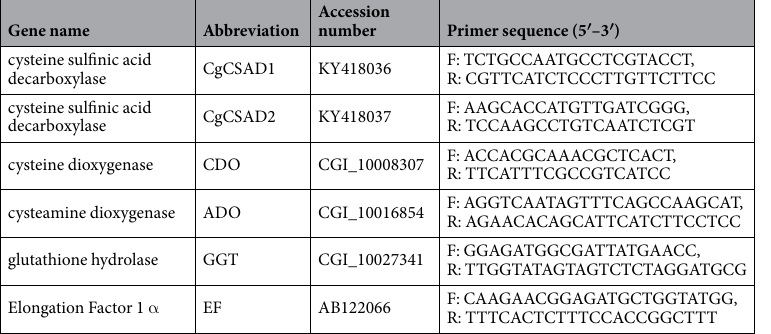
Table 2. The primer used in qPCR.